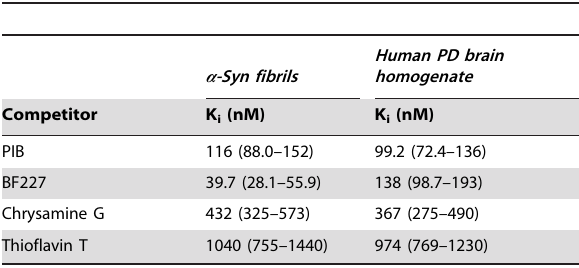
Table 4. K i values of previously reported ligands for a -syn fibrils determined in [ 125 I]SIL23 competitive binding assays with recombinant a -syn fibrils and PD